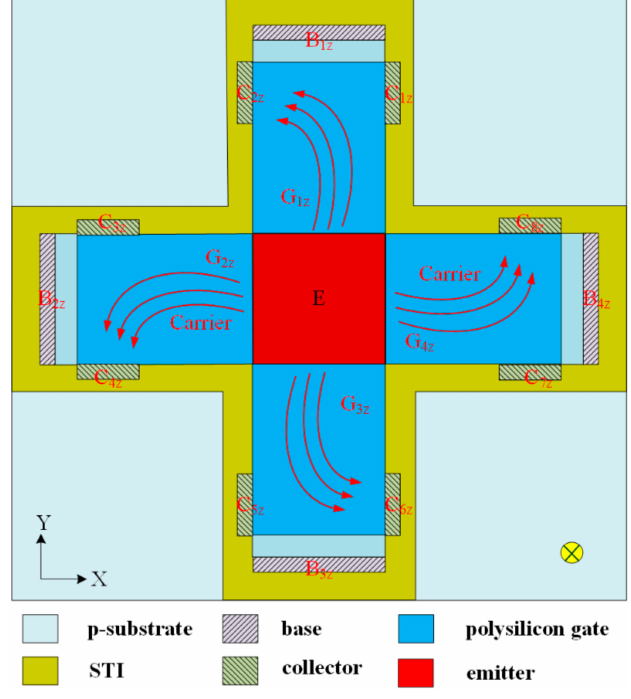
Figure 2. Structure of the